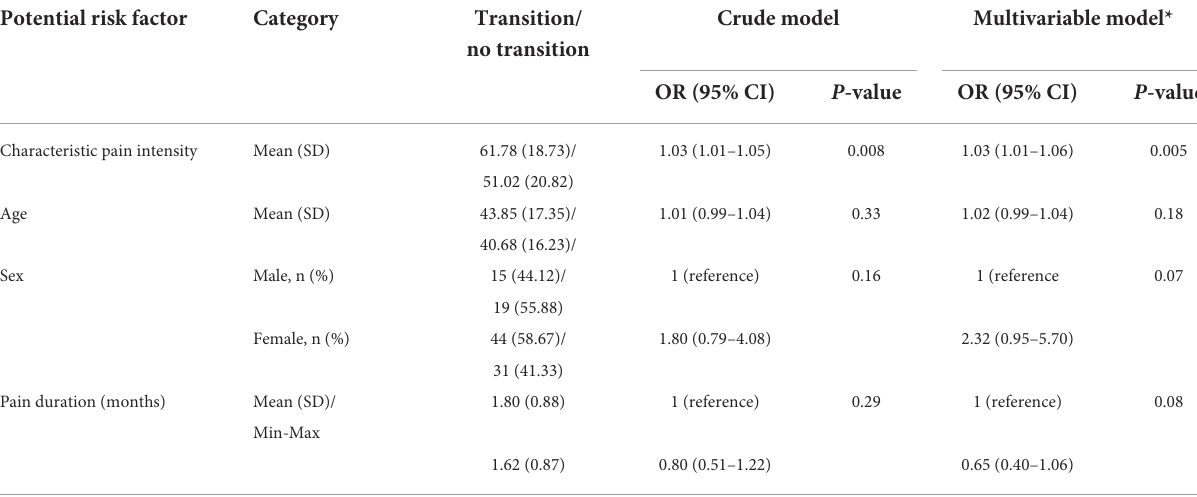
TABLE 1 Binary logistic regression analyses assessing the association between CPI, age, and sex and the acute to chronic transition at 3 months of follow-up. Potential risk factor